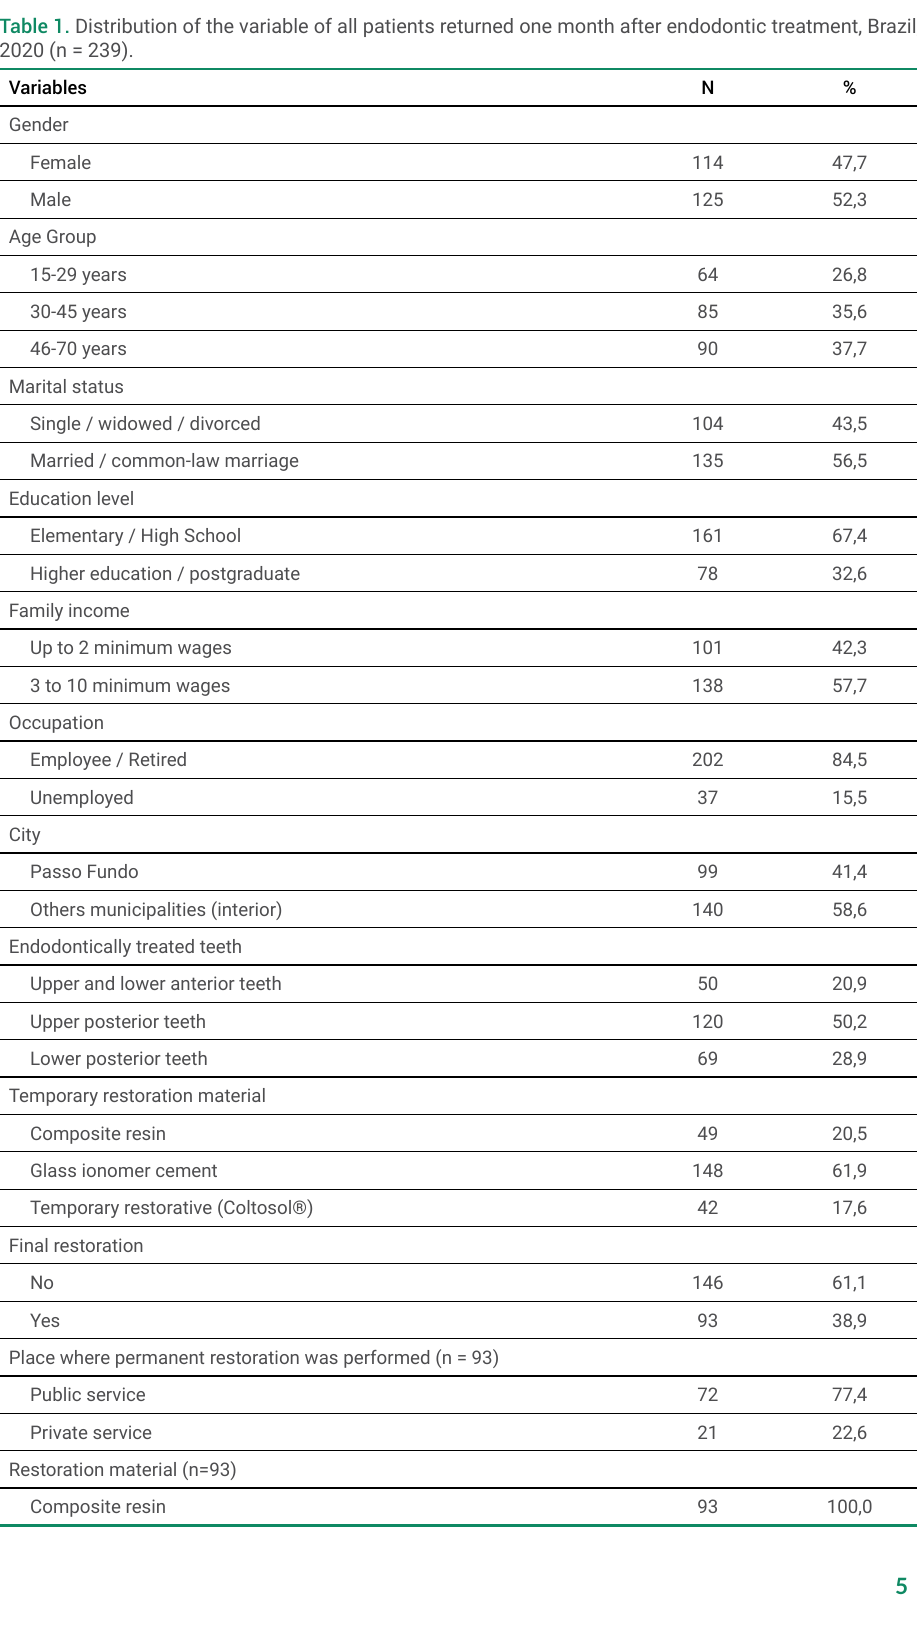
Table 1. Distribution of the variable of all patients returned one month after endodontic treatment, Brazil, 2020 (n = 239). Variables N